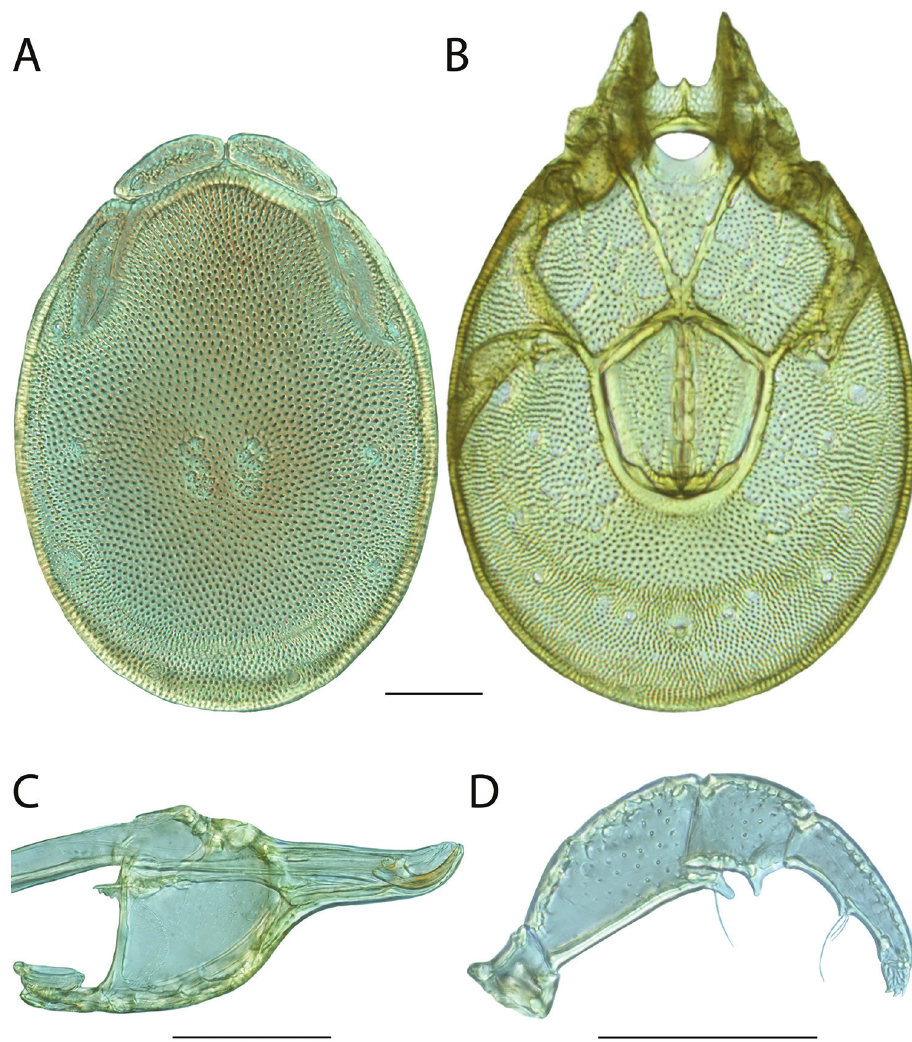
Figure 168. Torrenticola nortoni sp. n. female: A dorsal plates B venter (legs removed) C subcapitulum D pedipalp (setae not accurately depicted). Scale = 100 µm. m ale (Figure 169) (n = 5) (allotypic measurements in parentheses when available) with characters of the genus with following